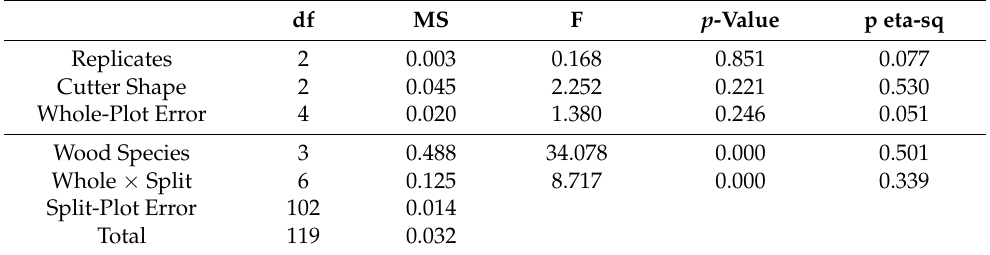
Table 2. Results of split-plot ANOVA on respirable mass concentration data.